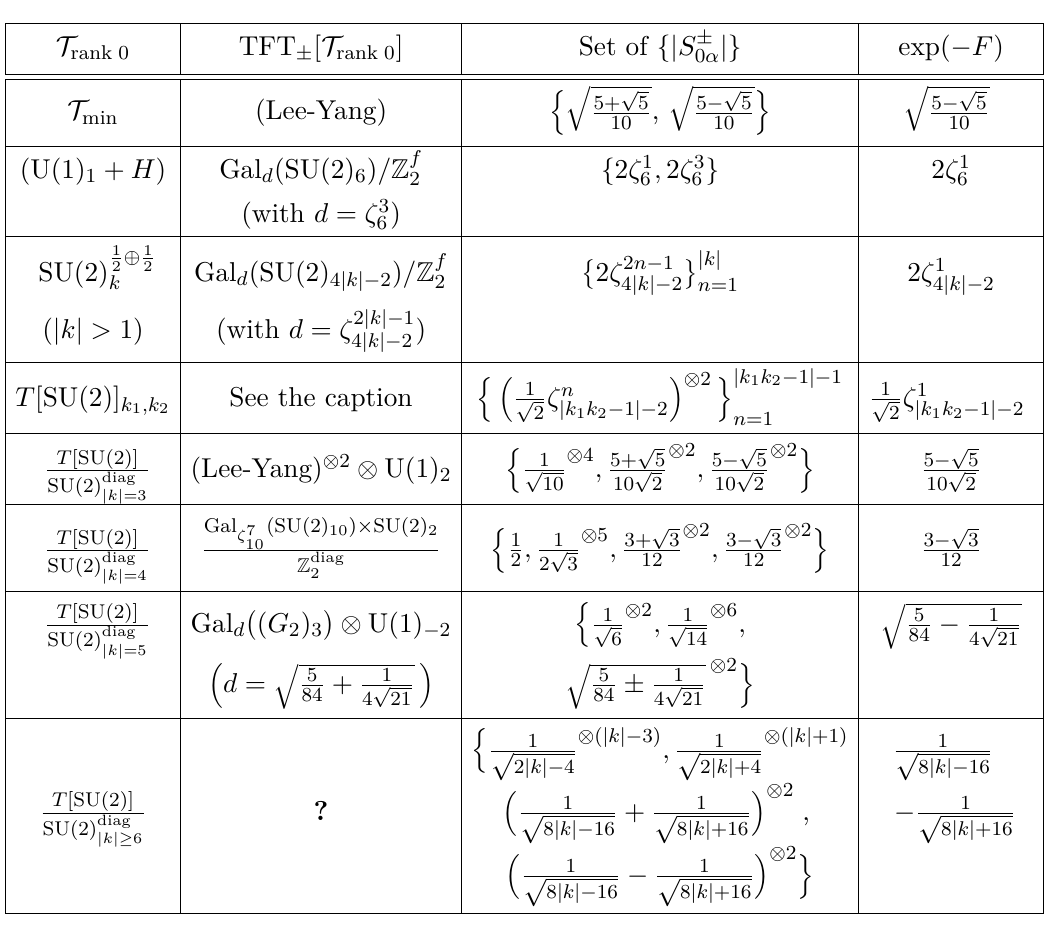
Table 2 . Non-unitary TQFTs from rank 0 N = 4 SCFTs. Gal d ( TFT ) denotes a